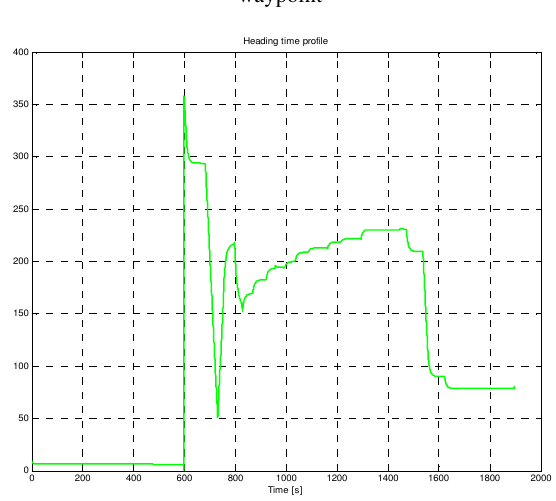
Fig 11. Aerodynamic bank angle as requested by the guidance system’s algorithm. In most of the curves, the algorithm uses the maximum allowed bank angle (30 degrees) to more quickly align the heading with the direction that leads to the next waypoint